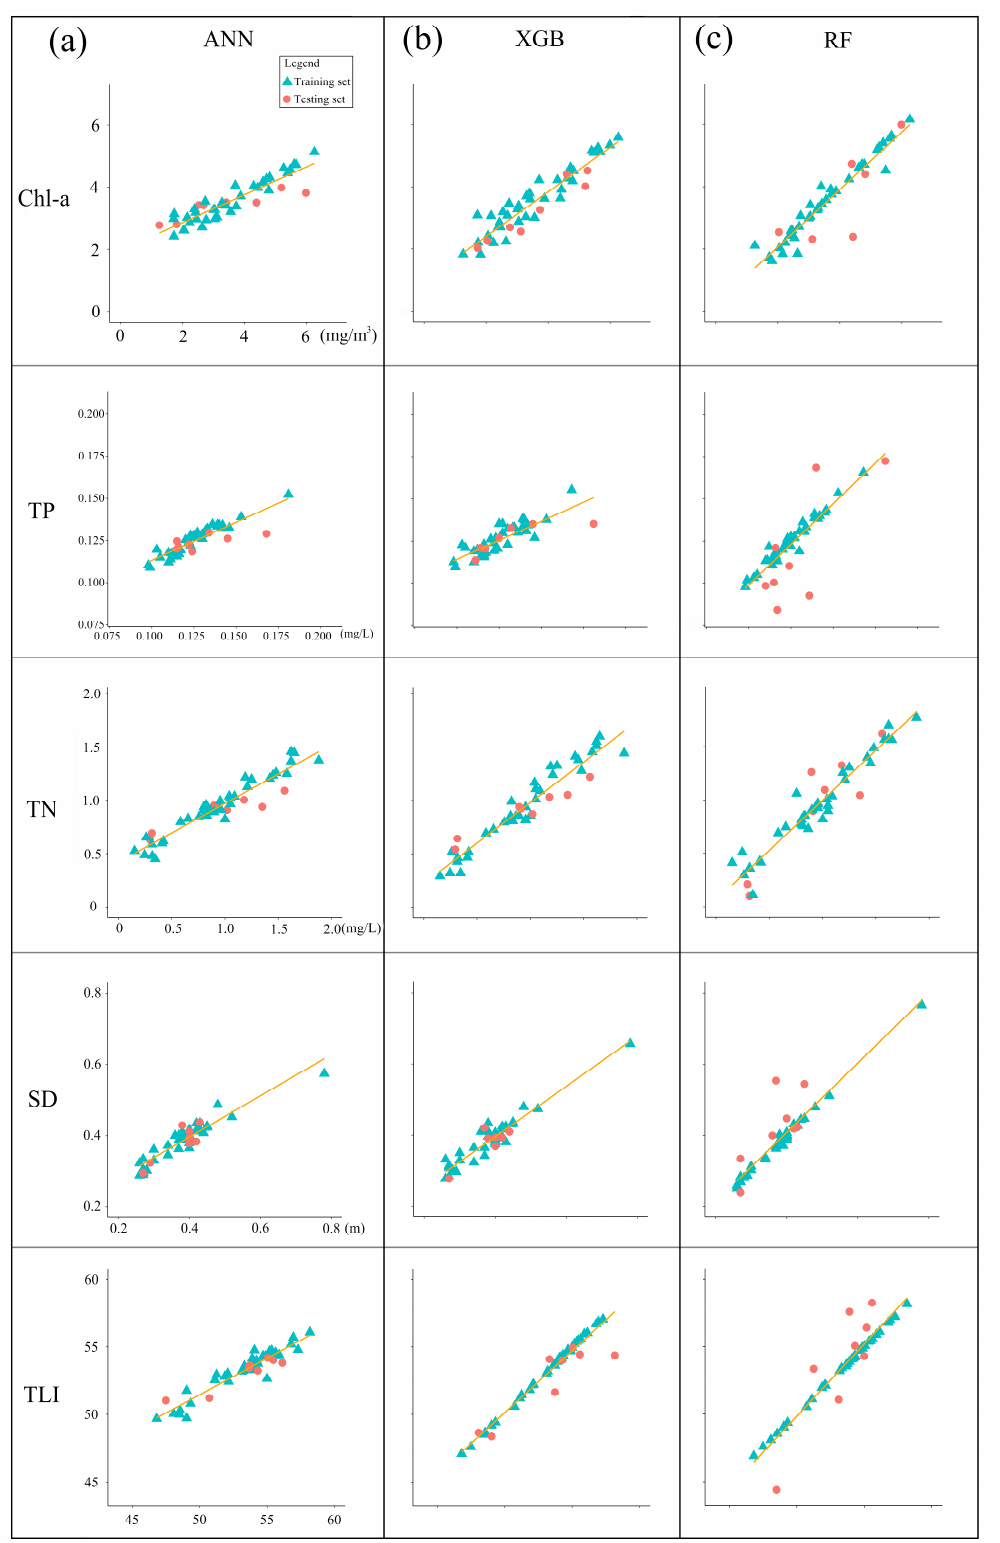
Figure 5. The scatter plots for the predicted and in situ values of each water quality parameter based on the following models:( a ) RF, ( b ) XGB, ( c )ANN.